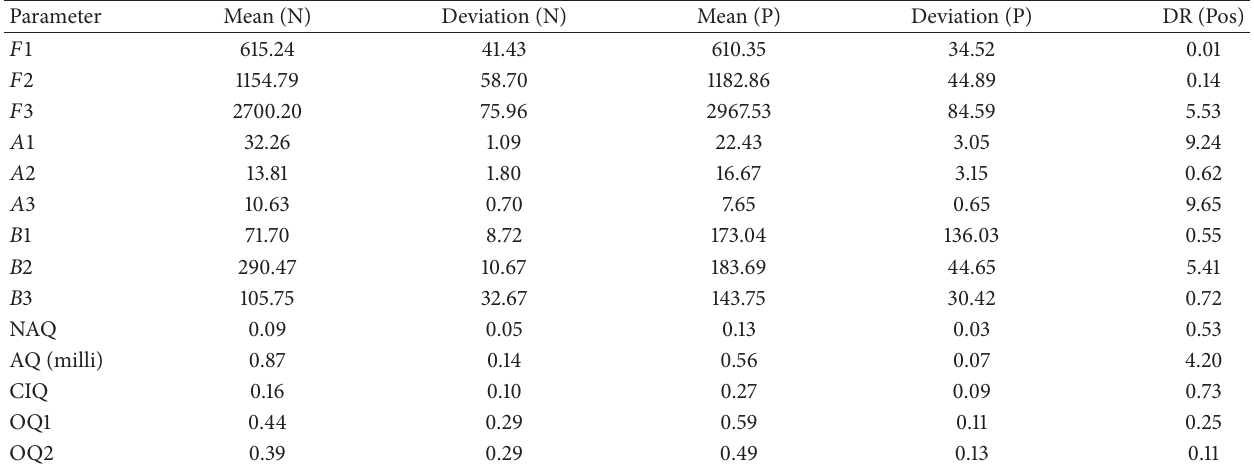
Table 6: DR evaluation table for vowel /aa/ for speaker JE.